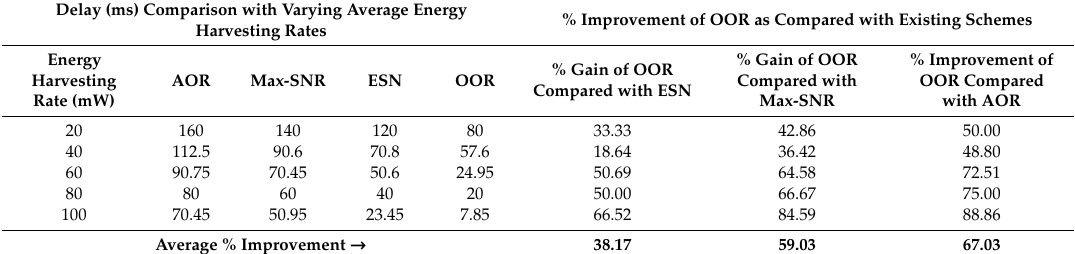
Table 4. Descriptive observations of OOR performance in terms of delay (second scenario).